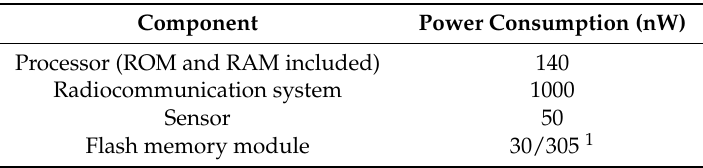
Table 5. Power consumption per